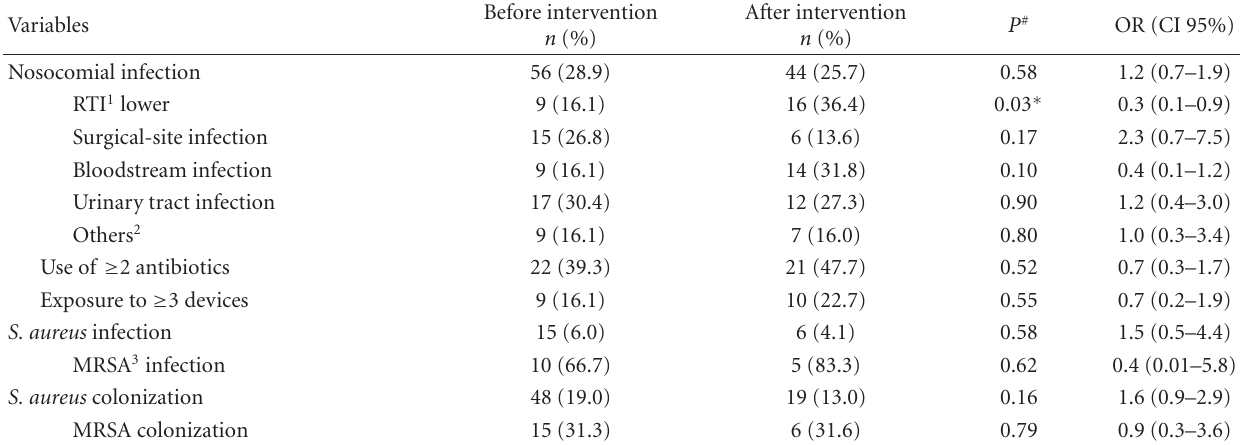
Table 2: Frequency of nosocomial infection, infection/colonization by MRSA before, and after intervention. OR = odds ratio and CI = confidence